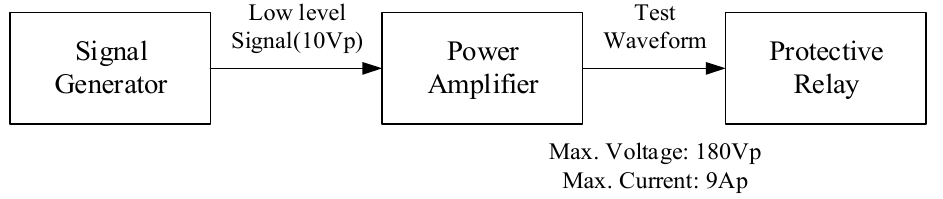
Figure 4. Hardware configuration diagram of the PREDIS-R.